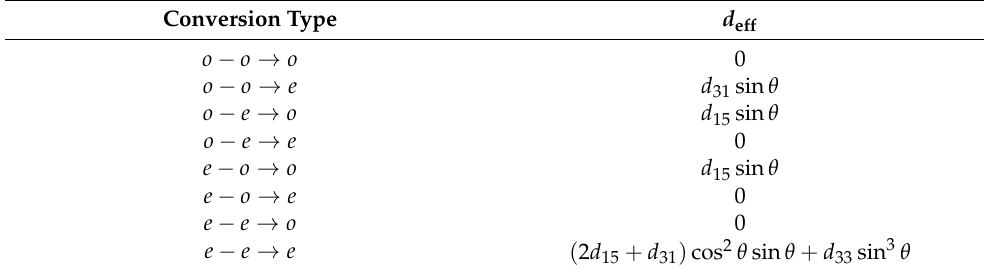
Table 2. Effective nonlinear coefficients for eight possible types of conversion in the LB4 crystal. Conversion